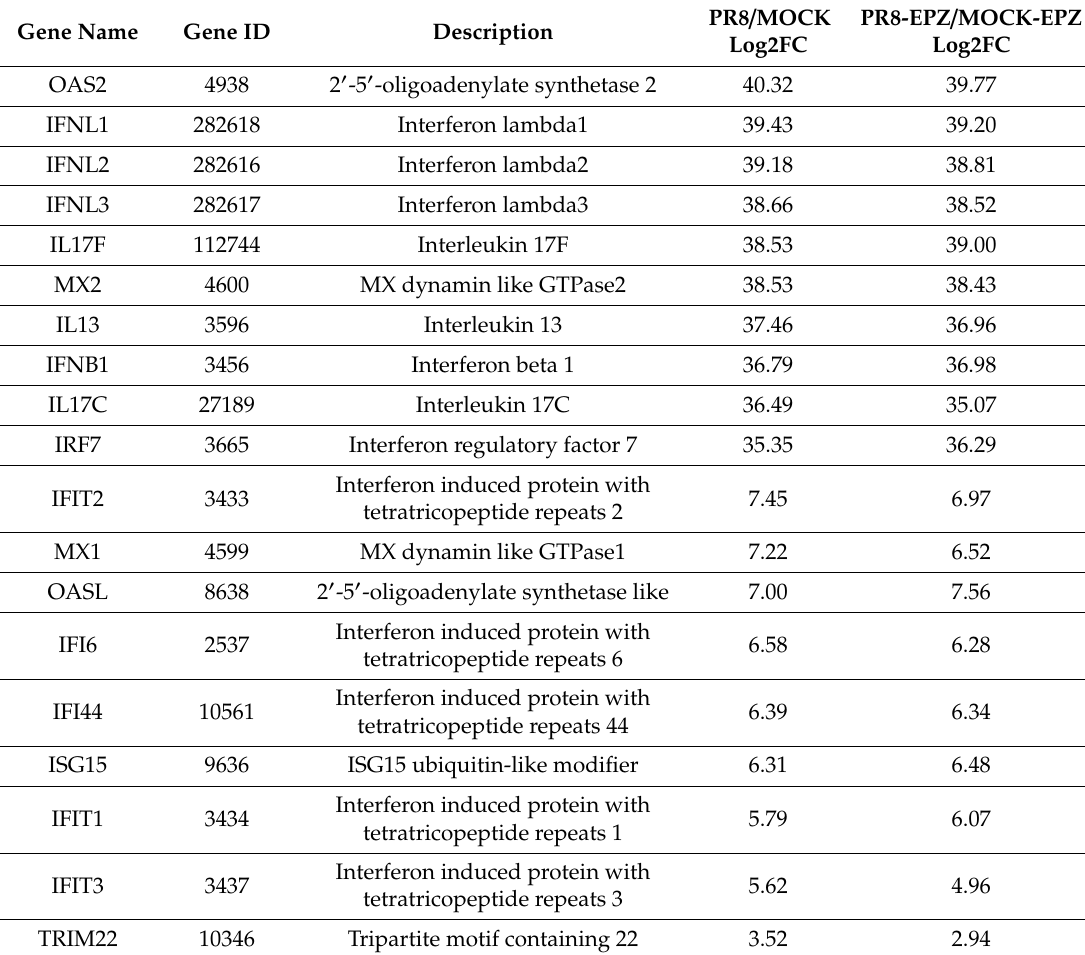
Table 1. Cellular genes involved in the IFN response di ff erentially modified during influenza virus infection in Dot1L inhibited A549